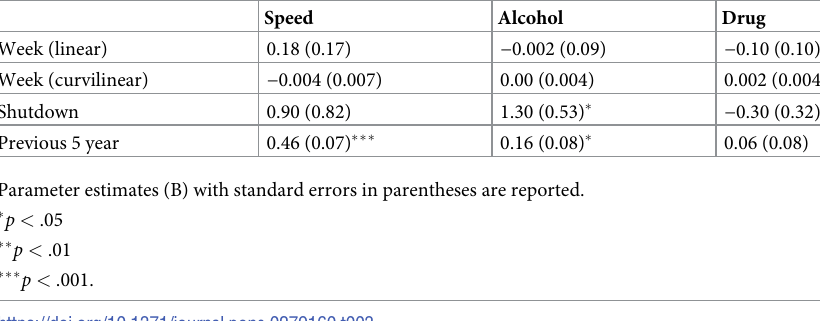
Table 3. Effects of week (linear and curvilinear) and shutdown. Speed Alcohol Drug Week (linear) 0.18 (0.17)